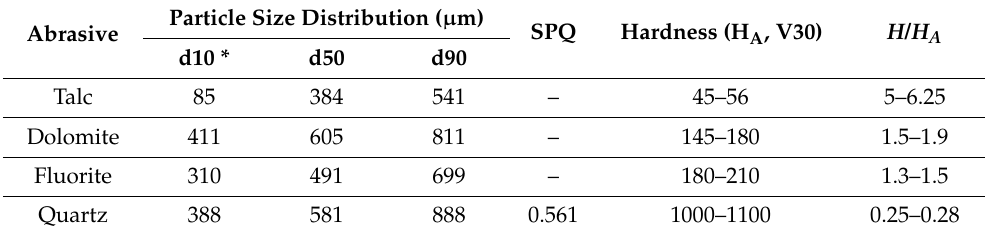
Table 2. Properties of the abrasives used in the